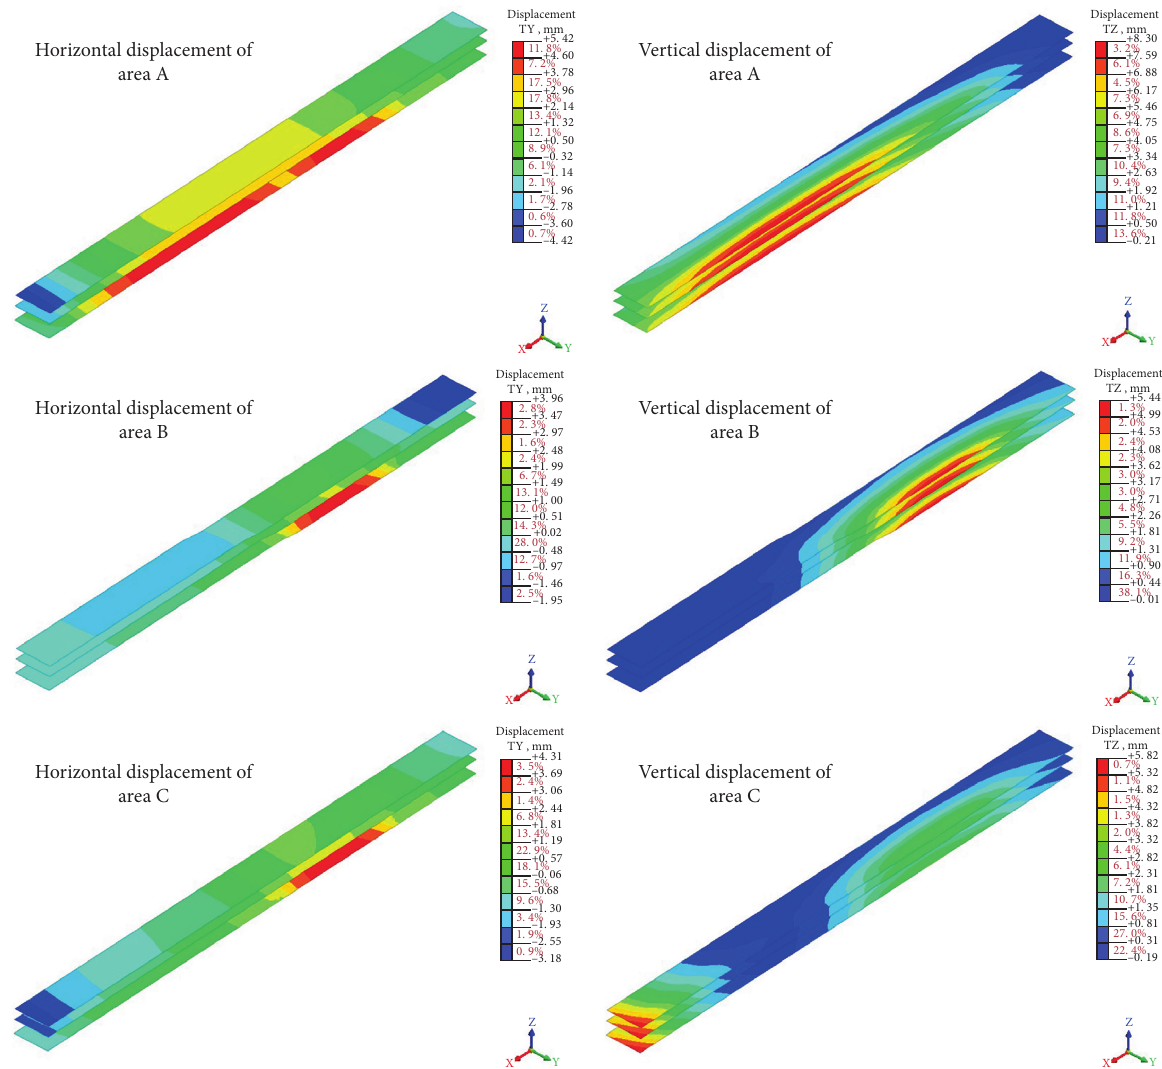
Figure 4: Horizontal and vertical displacements due to foundation pit excavation in the pit bottom station of each